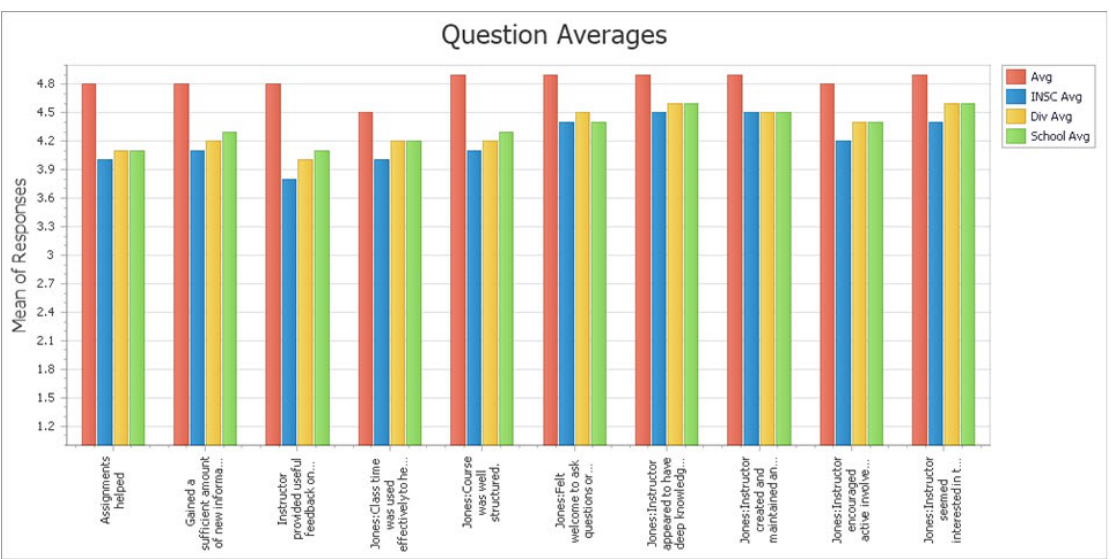
Figure 2. Honors student perceptions of teaching- average scores (Avg red) for the PjBL course, compared to the averages in the department (INSC Avg, blue), division (Div avg, yellow) and school (School Avg, green). Note: Avg stands for average